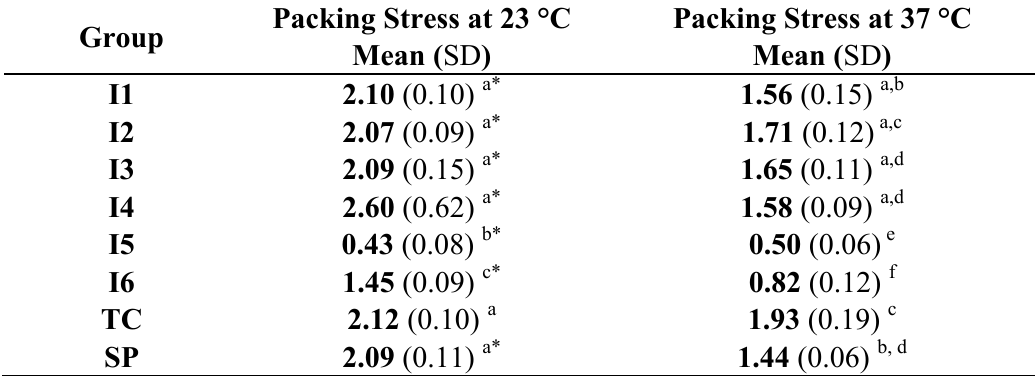
Table 2. Mean (SD) values of viscosity (MPa.s) of different resin composites at 23 °C and 37 °C.